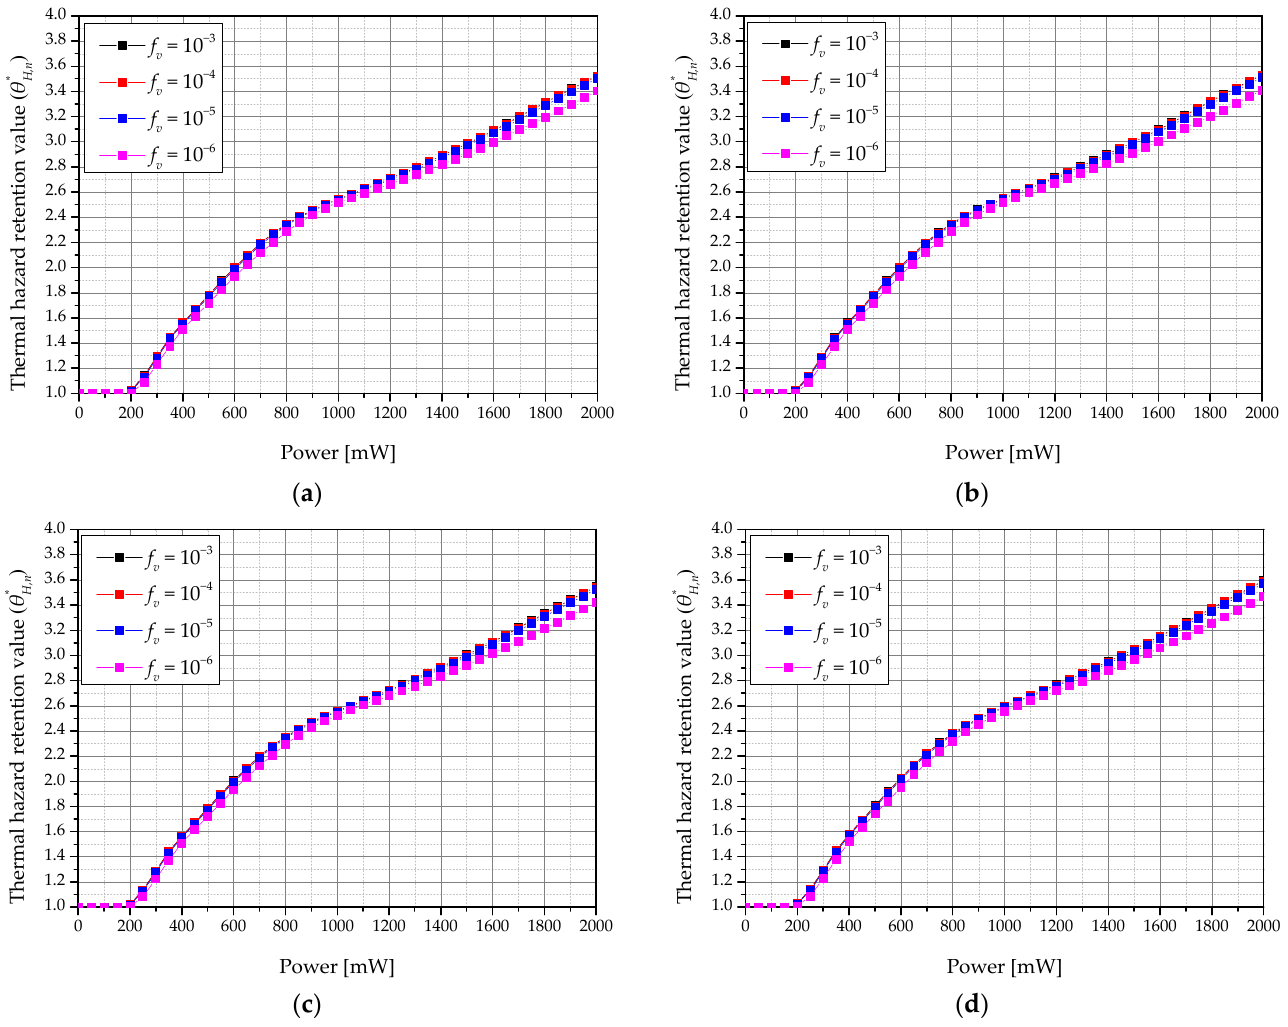
Figure 11. Thermal hazard retention value of normal tissue ( 𝜃 (cid:3009),(cid:3041)∗ ) for various volume fraction of GNR ( f v ) ( τ tot = 960 s). ( a ) τ h & τ c = 15 s; ( b ) τ h & τ c = 20 s; ( c ) τ h & τ c = 30 s; ( d ) τ h & τ c = 60 s.